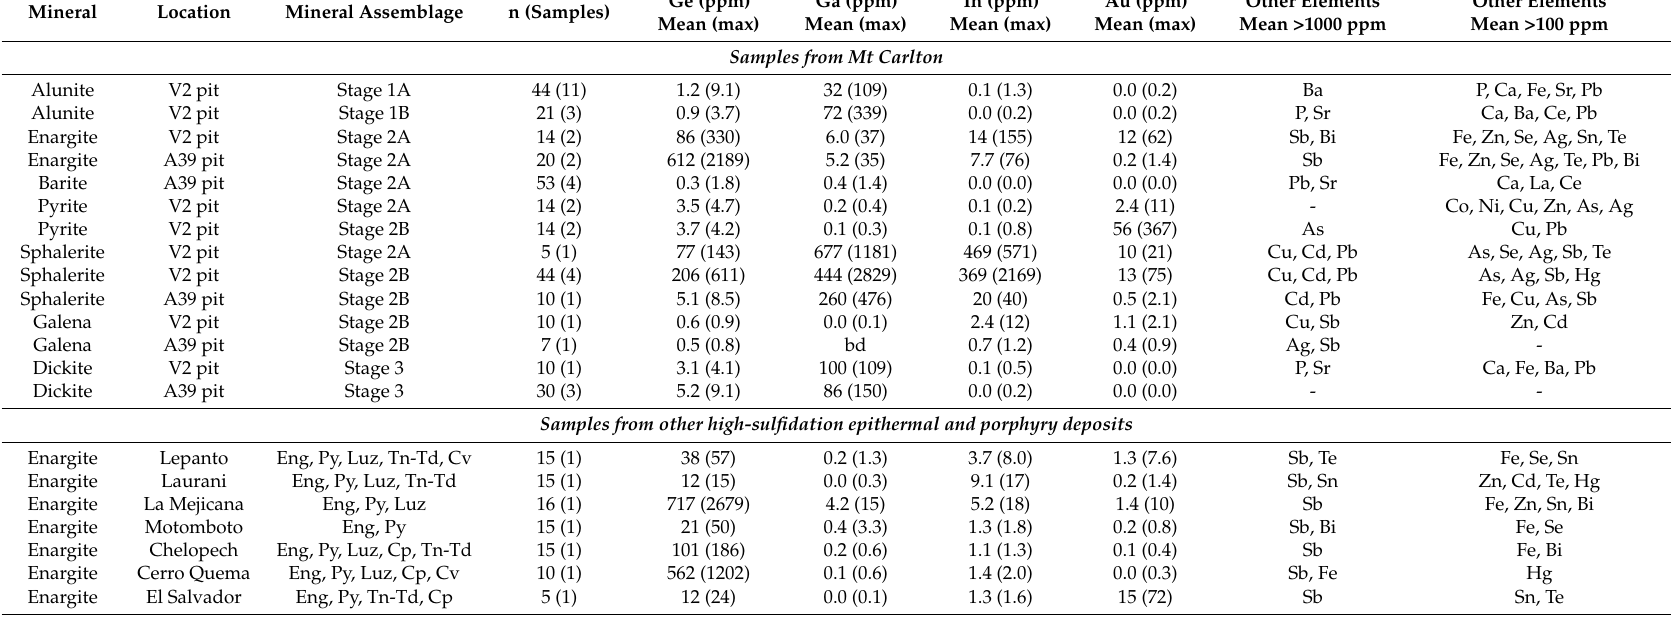
Table 3. Summary table of LA-ICP-MS trace element compositions of minerals from Mt Carlton and similar deposits